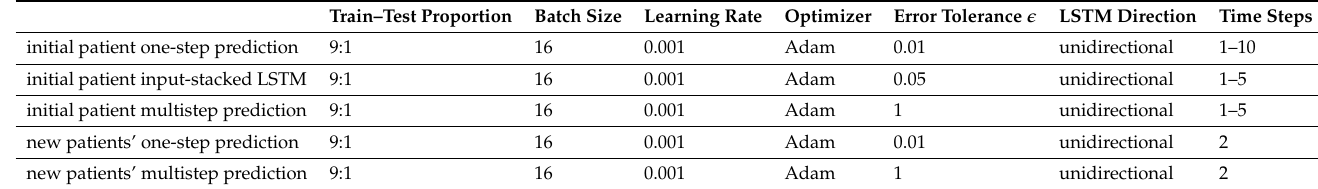
Table 2. Hyperparameters of the LSTM